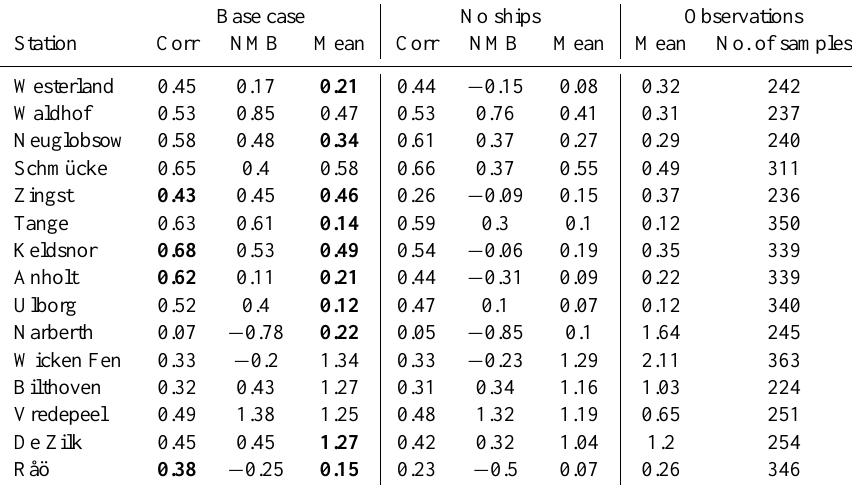
Table 6. Comparison of simulated SO 2 concentrations with observations in µgm − 3 . Values that are significantly different between the base case and the no-ships case are printed in